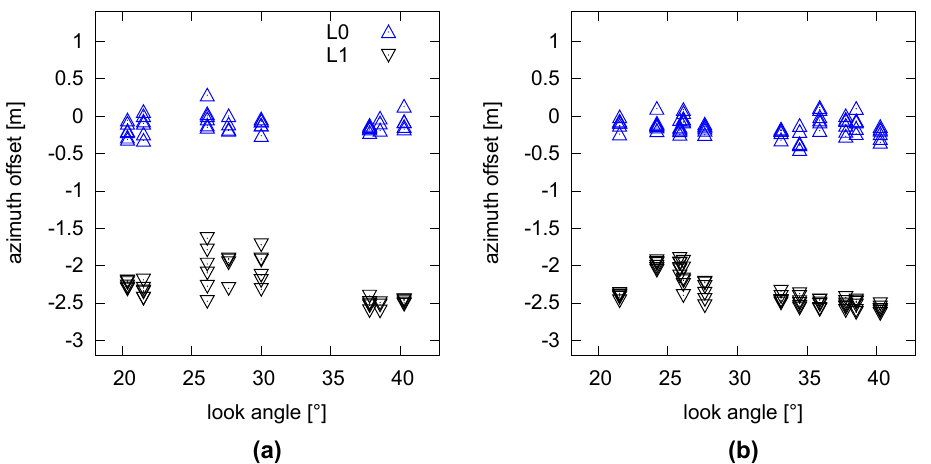
Figure 7. Azimuth offset derived from corner reflector responses for S-1A ( a ) and S-1B ( b ) obtained using both product types: L0 products (blue) and L1 products (black).